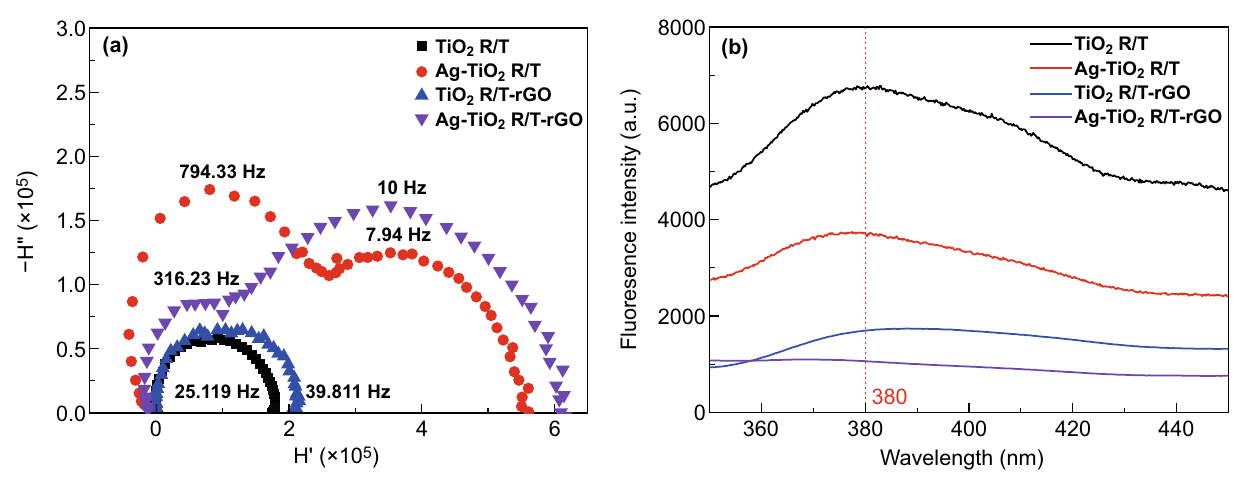
Fig. 10 a IMPS plots and b PL spectra with the excited wavelength at 260 nm of TiO 2 R/T, Ag-TiO 2 R/T, TiO 2 R/T-rGO, and Ag-TiO 2 R/T-rGO